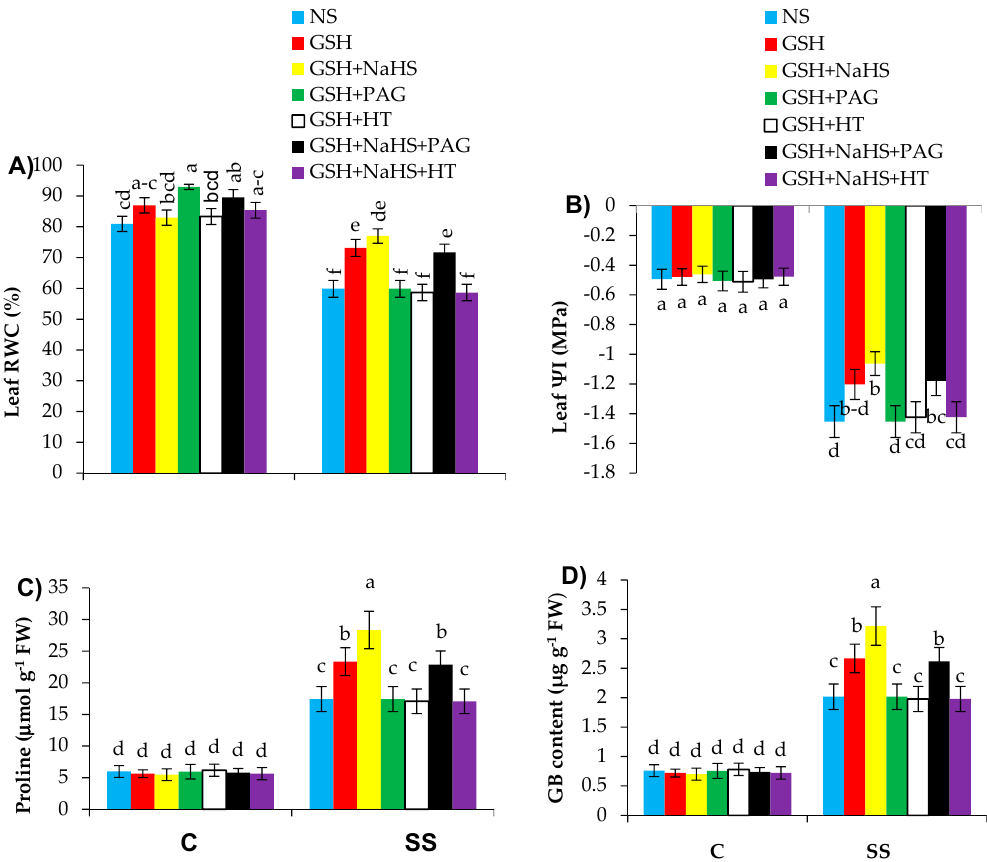
Figure 4. Leaf relative water content (RWC; ( A )), leaf water potential ( Ψ l; ( B )), proline ( C ), and glycine betaine (GB; ( D )) contents in pepper plants grown under control (C) and salinity stress (SS 100 mmol L − 1 NaCl), sprayed with glutathione (1.0 mmol L − 1 GSH) or sodium hydrosulfide (0.2 mmol L − 1 NaHS) alone or together, combined with a 0.1 mmol L − 1 scavenger of H 2 S, hypotaurine (0.1 mmol L − 1 HT), or inhibitor of l -DES, dl -propargylglycine (0.3 mmol L − 1 PAG). (Mean ± SE). Mean values carrying di ff erent letters within each parameter di ff er significantly ( p ≤ 0.001) based on Duncan’s multiple range